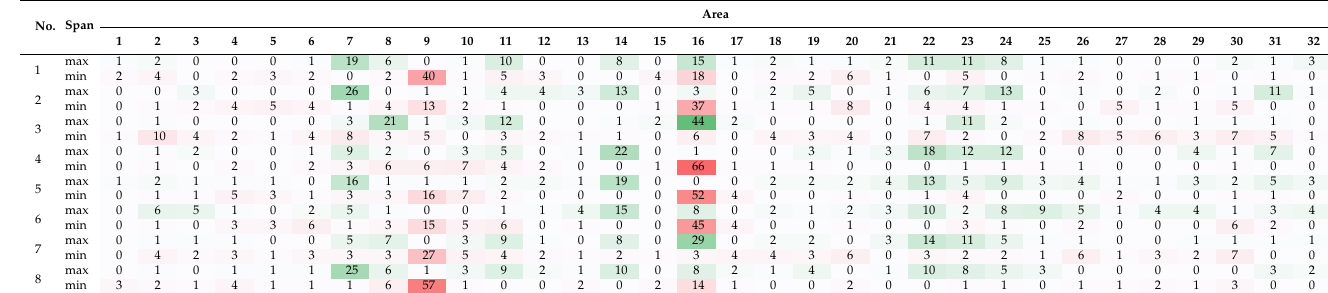
Table 3. Number of times when specific areas were chosen in the control